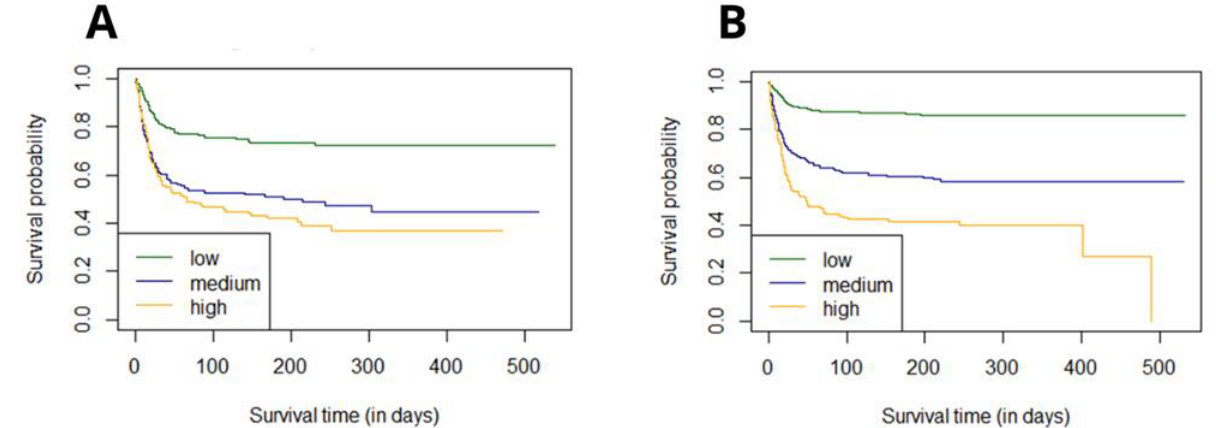
Figure 4. Analysis of the 6-month survival for the low, medium, and high C 2 HEST risk strata in the diabetic ( A ) and non-diabetic ( B ) cohorts.